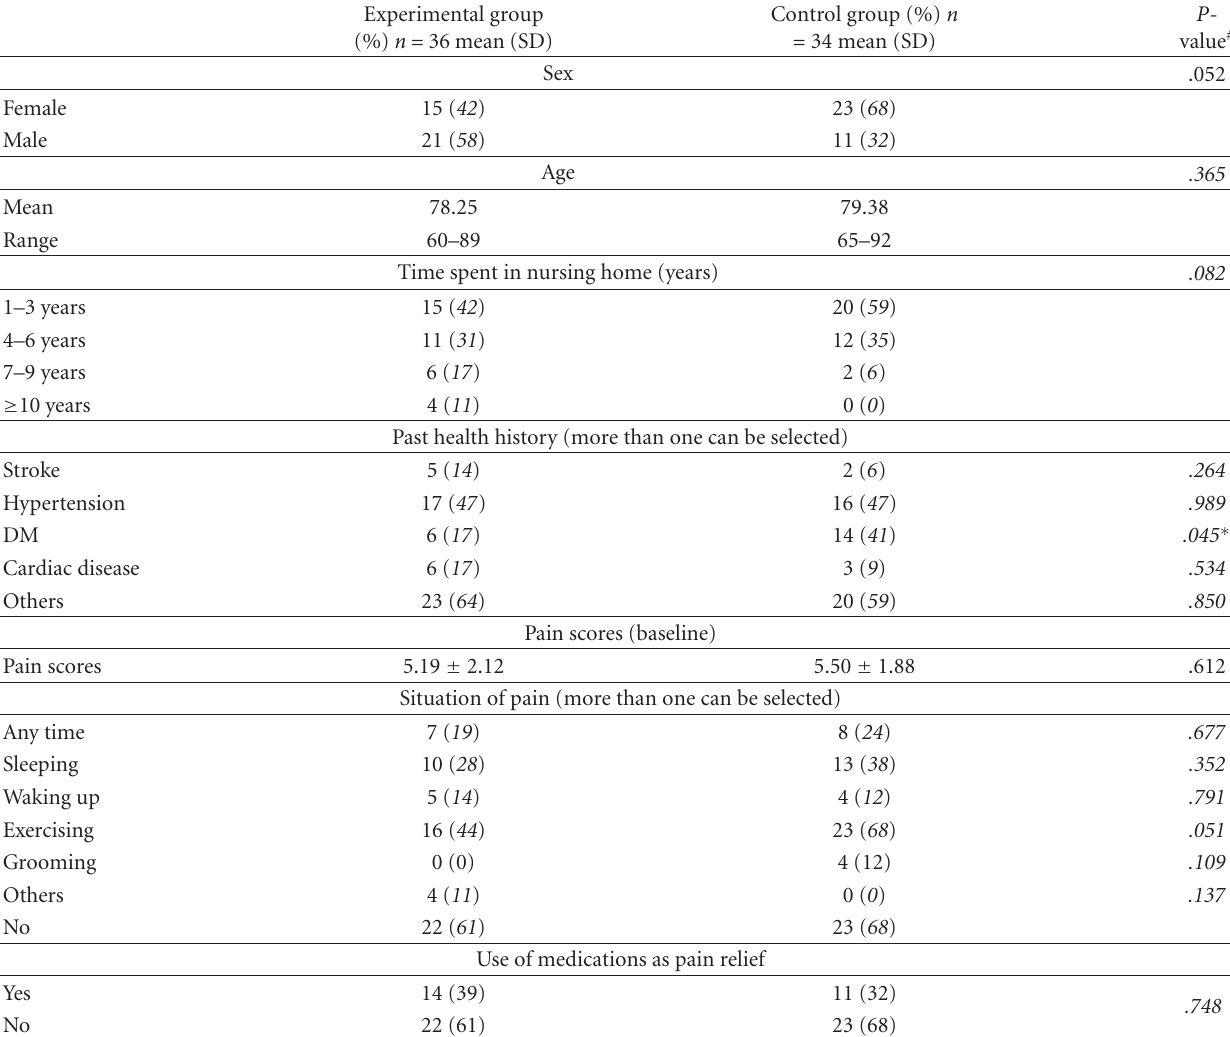
Table 1: Demographic data for participants of experimental and control